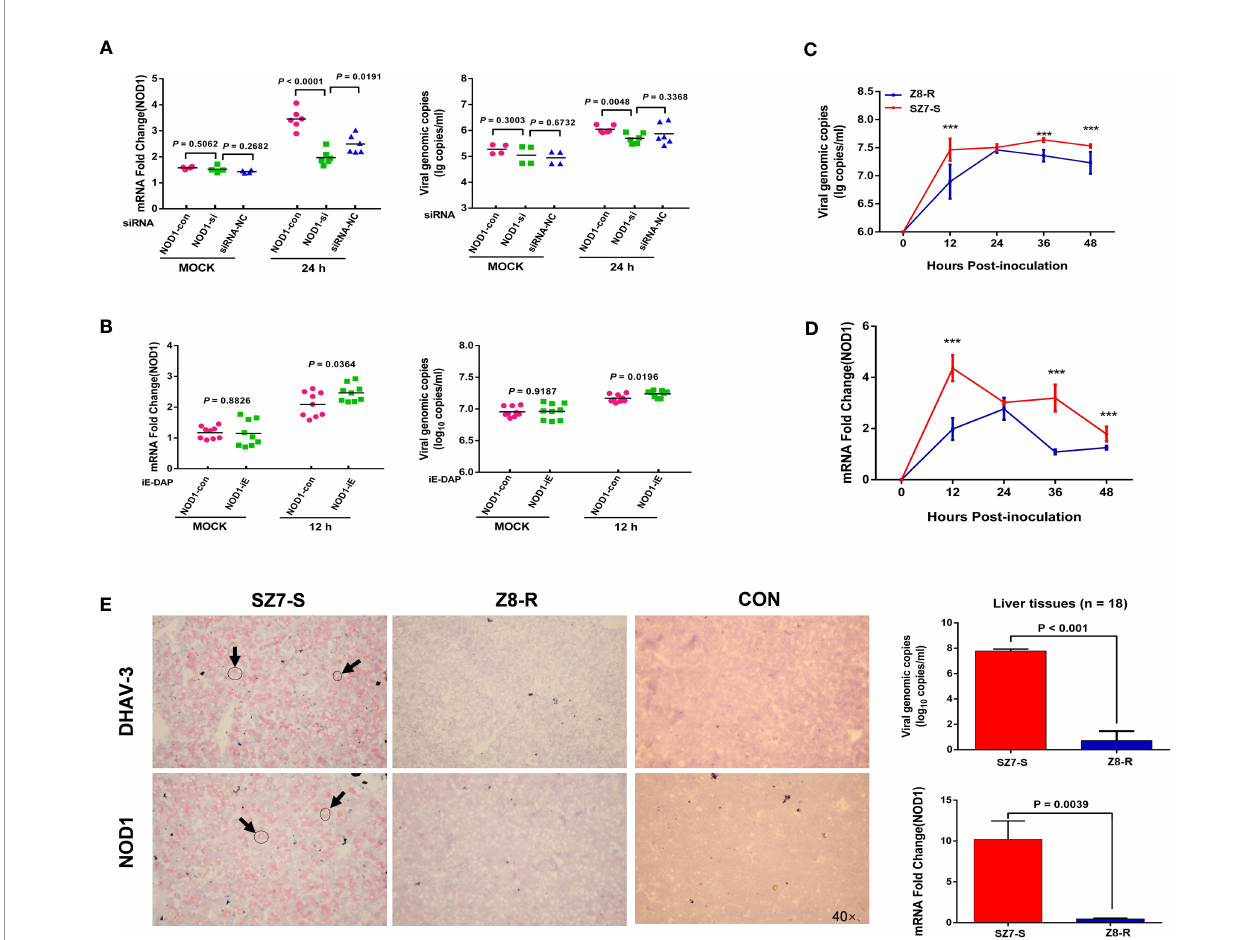
FIGURE 5 | NOD1 is correlated with DHAV-3 infection. (A) RT-qPCR analysis of NOD1 and DHAV-3 mRNA expression in primary liver cells. Cells of the MOCK group were sampled at 12 hpi. (B) RT-qPCR analysis of NOD1 and DHAV-3 mRNA expression in primary liver cells. Cells were treated with iE-DAP (50 m g/ml) for the indicated times. Cells of the MOCK group were sampled at 12 hpi. (C, D) The kinetics of DHAV-3 and NOD1 expression in primary liver cells. The results are presented as the means ± SD of at least three independent experiments. *** P < 0.001. (E) DHAV-3 and NOD1 were detected by the RNAscope in situ hybridization method, and RT-qPCR was used to determine the expression of NOD1 and the genomic copy numbers of DHAV-3. Statistical analysis was performed by Student ’ s t-test, and error bars indicate the standard error of the mean (SEM). Images were acquired with an OLYMPUS microscope. Oil objective: 40×; zoom in